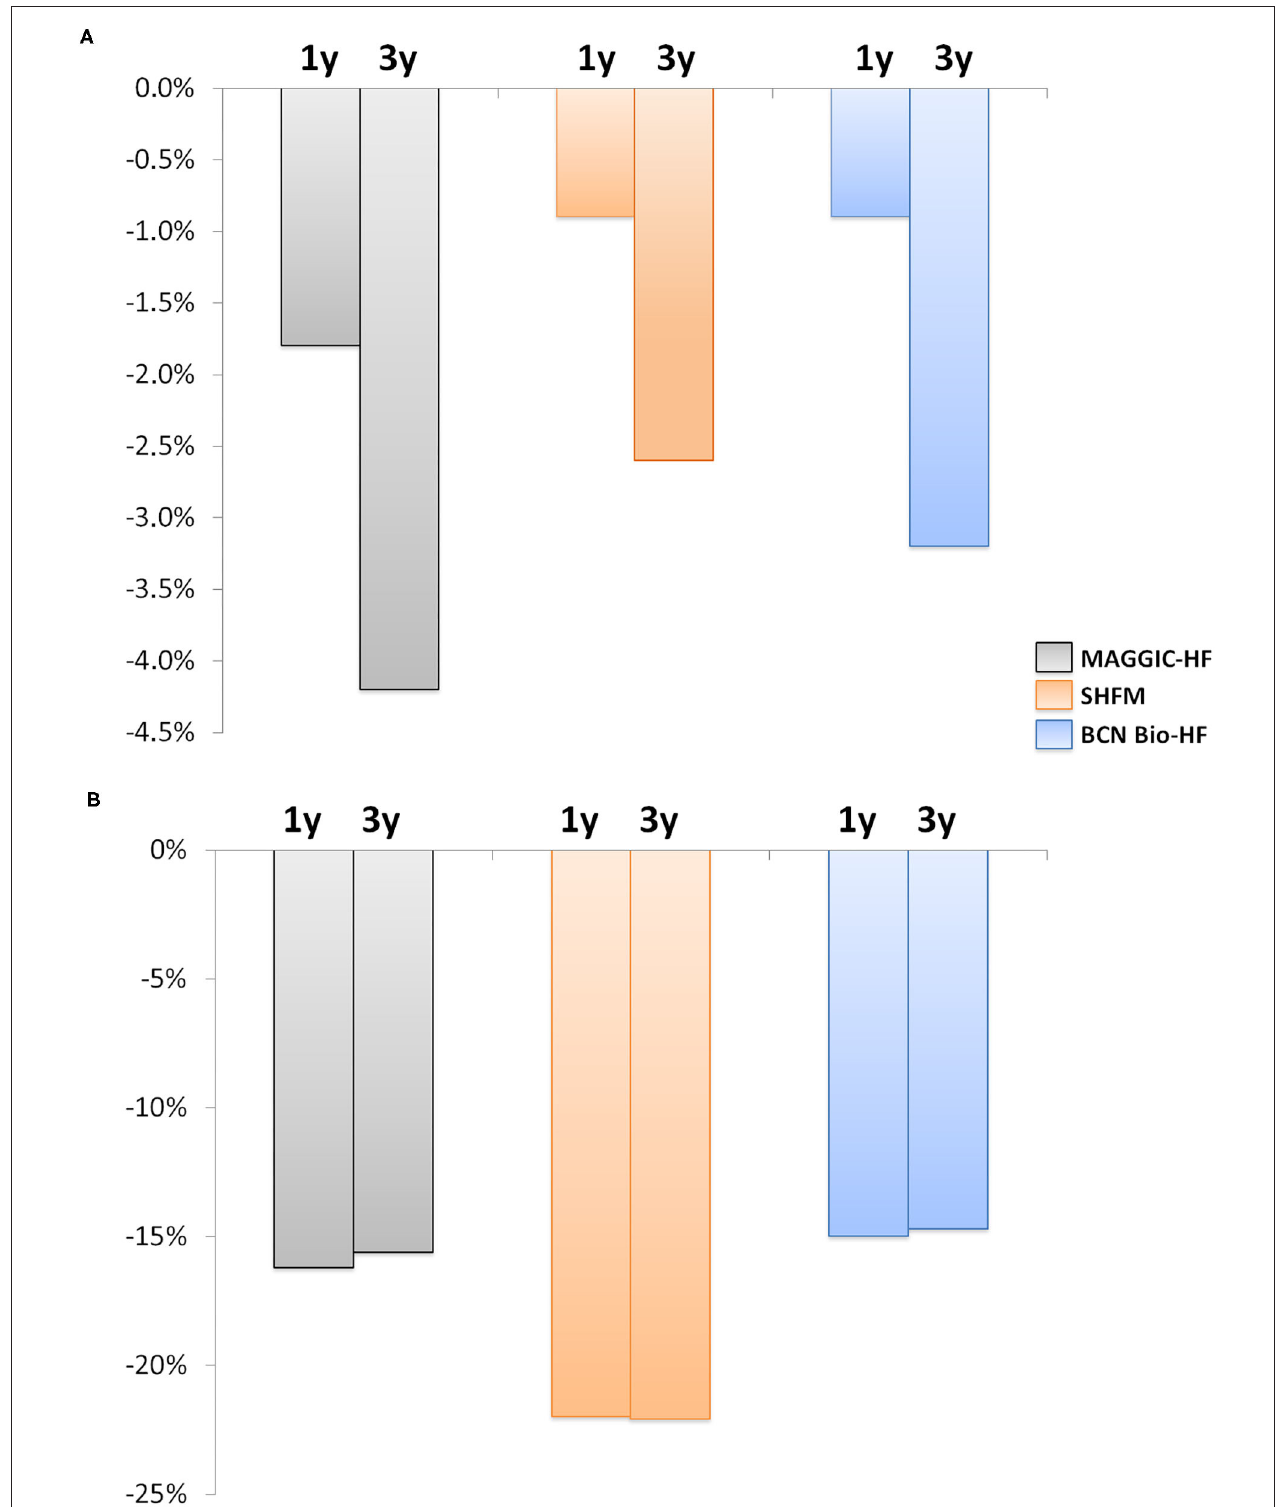
FIGURE 3 | Change in the risk of all-cause death at 1 and 3 years after 12 months of follow-up. (A) Absolute risk change. (B) Relative risk change. The estimated risk of death decreased significantly with the three calculators (all p < 0.001). Gray, MAGGIC; Orange, SHFM; Blue, BCN Bio-HF.